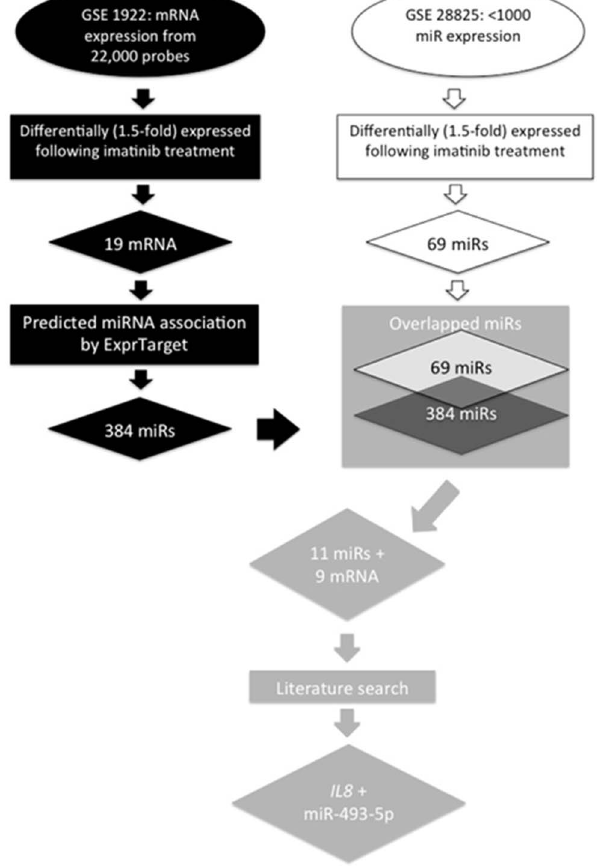
Fig. 1. Work flow for identifying imatinib response biomarkers through an informatics approach in K562